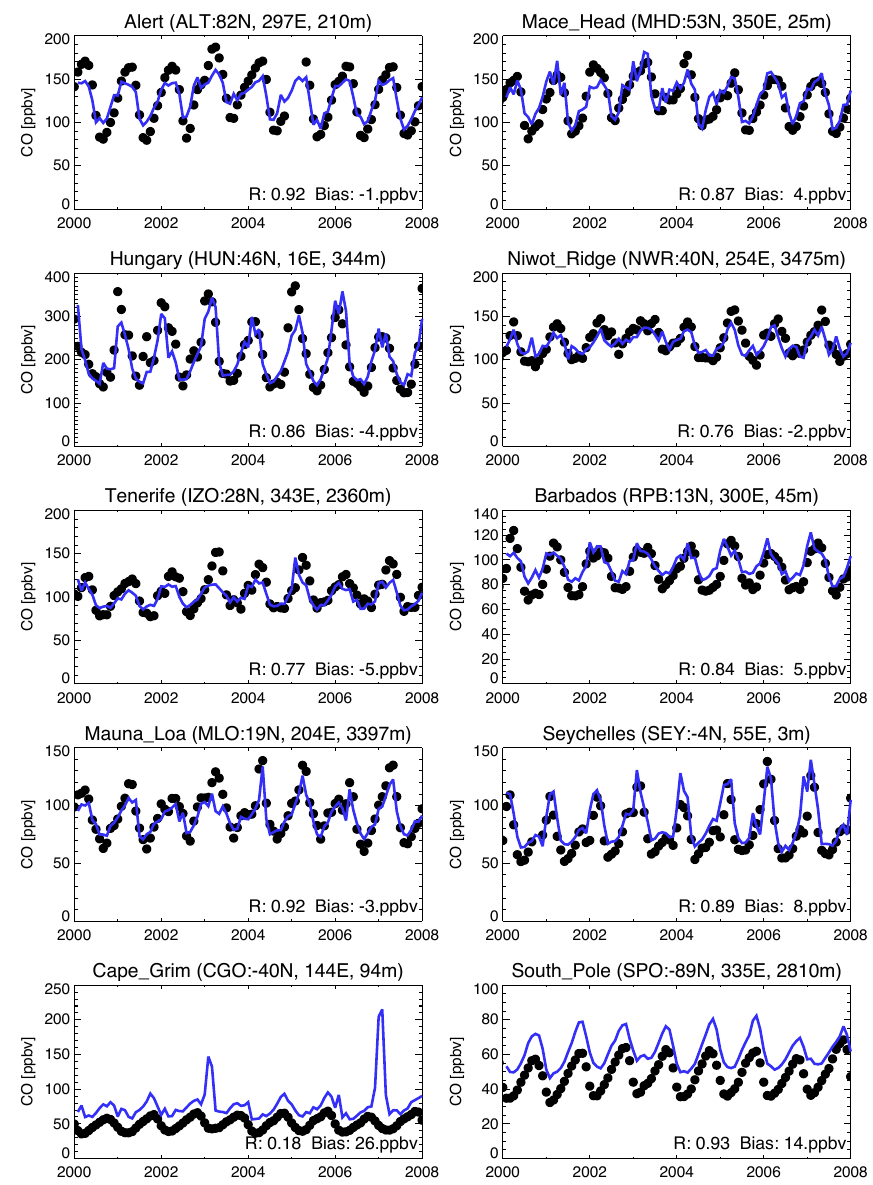
Fig. 5. Comparison of MOZART-4 CO (blue line) to NOAA GMD surface CO measurements (black dots) at selected network sites. MOZART-4 results correspond to the pressure altitude of each observation site. Measurements are monthly averages of approximately weekly samples, while model results are averages of the complete